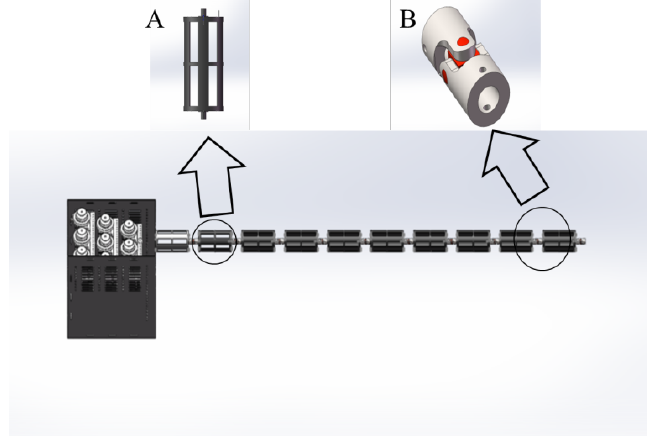
Figure 3. Structural model diagram of snake manipulator. ( A ) is the connecting rod structure and ( B ) is the universal joint